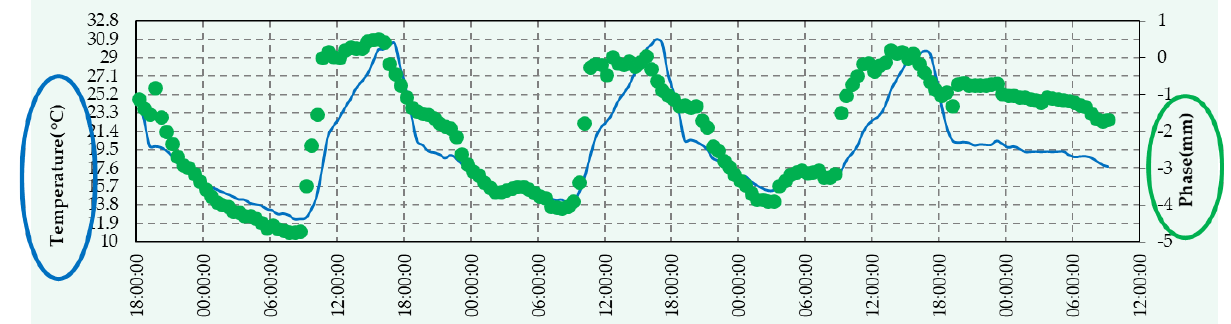
Figure 8. Displacement (phase) and temperature of the AR measured during the calibration. The blue line represents temperature (see the left y-axis), while the green dots indicate displacement values (see the right y-axis). Modified from Luzi et al.